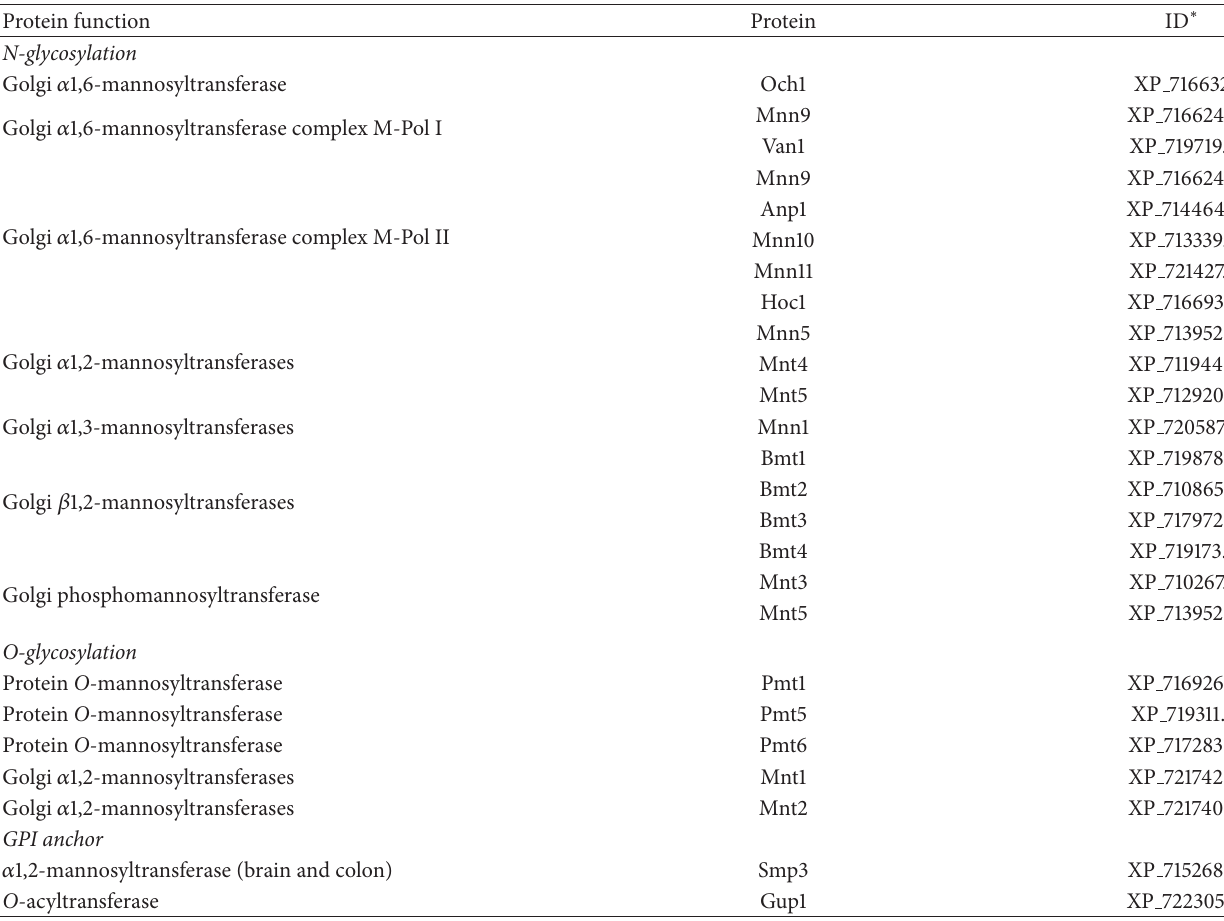
Table 2: C. albicans nonhomologous proteins involved in the N -linked, O -linked, and GPI-anchor pathways. Protein